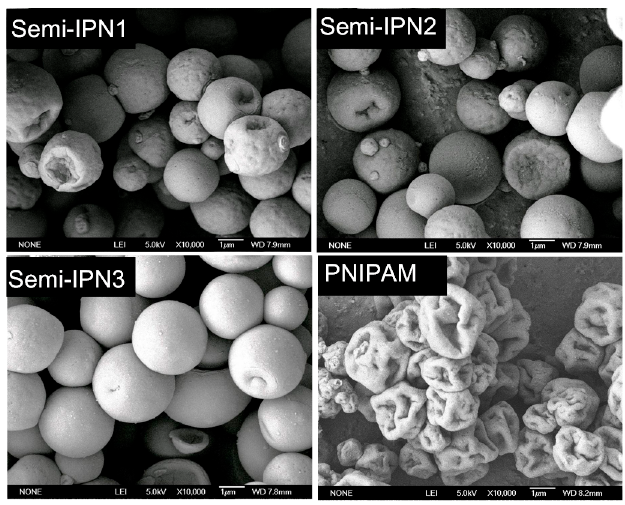
Figure 5. SEM images of semi-IPN and PNIPAM microspheres.